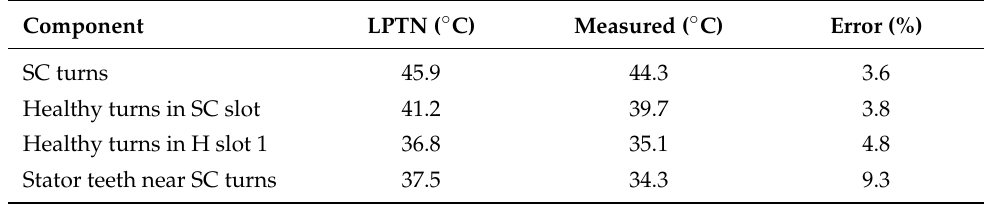
Table 7. Error between LPTN model and experimental